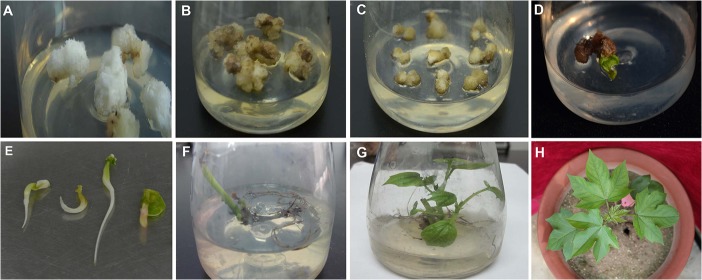
Embryo rescue of G. hirsutum × G. arboreum hybrid ovules.A, Ovules on MSB2K produced numerous fibers and calli; B, Ovules on MSB2K+1.0 mg l-1 IAA+0.2 mg l-1 Kin+250 mg l-1 CH produced numerous calli; C, Ovules on MSB2K+0.5 mg l-1 KIN+250 mg l-1 CH grew well, with little callus production; D, Ovule germination; E, Embryo isolation; F, All leaves of plantlets dropped; G, Healthy plantlets; H, Grafted plantlets.